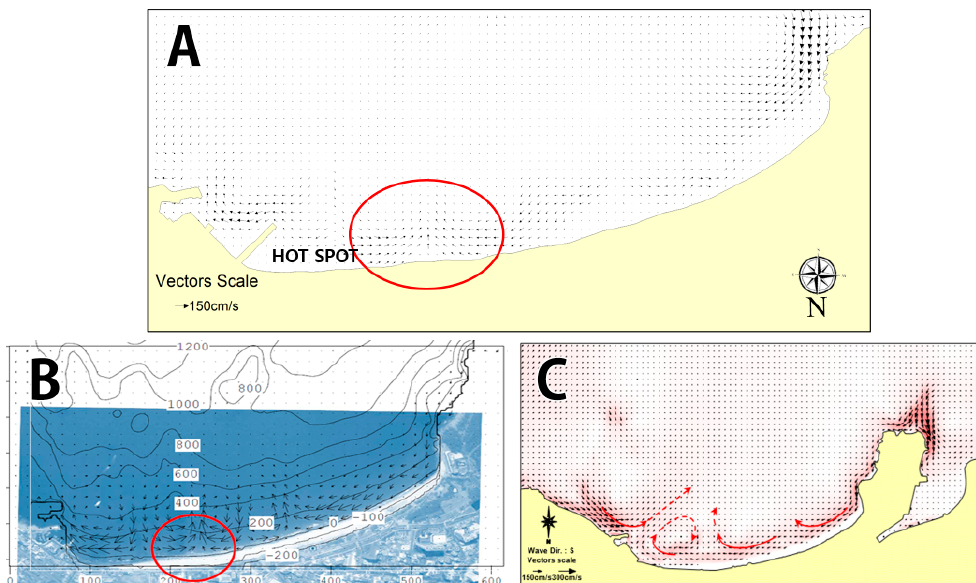
Figure 6. Results of the numerical simulations to predict hot spot of rip-current formation at Hae- undae Beach ( A ): Present research, ( B ): Duguchi et al., 2008 [13], ( C ): Kim et al., 2013 [14]). research, ( B ): Duguchi et al., 2008 [13], ( C ): Kim et al., 2013